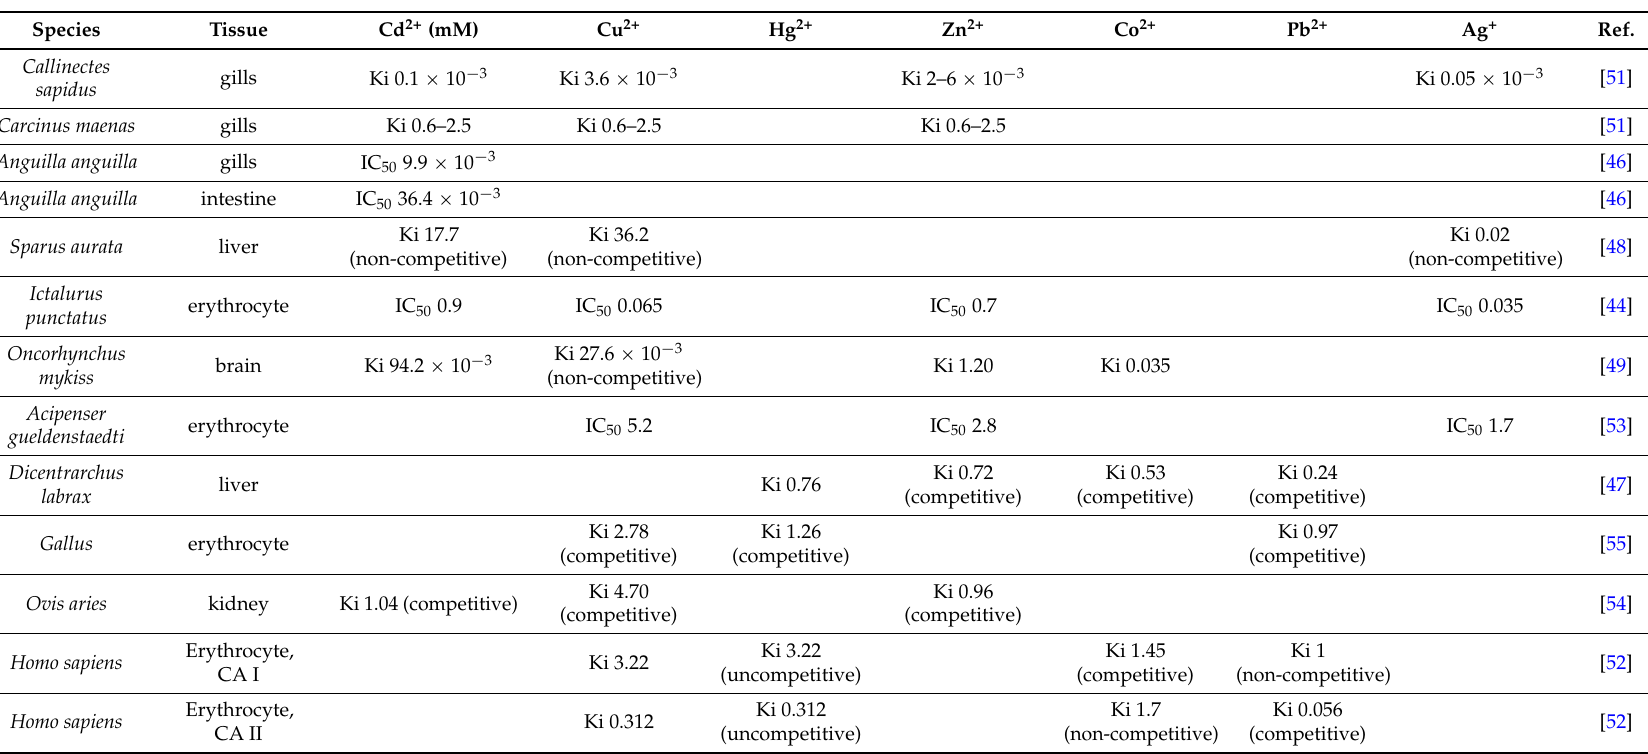
Table 2. In vitro inhibition of CA activity by trace metals. IC 50 and K i values are expressed as mM